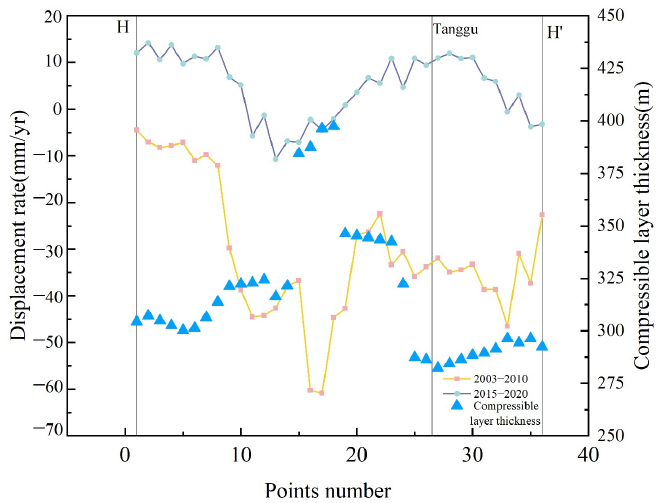
Figure 12. Land subsidence rate and compressed layer thickness along the H-H (cid:48) profile at the two time